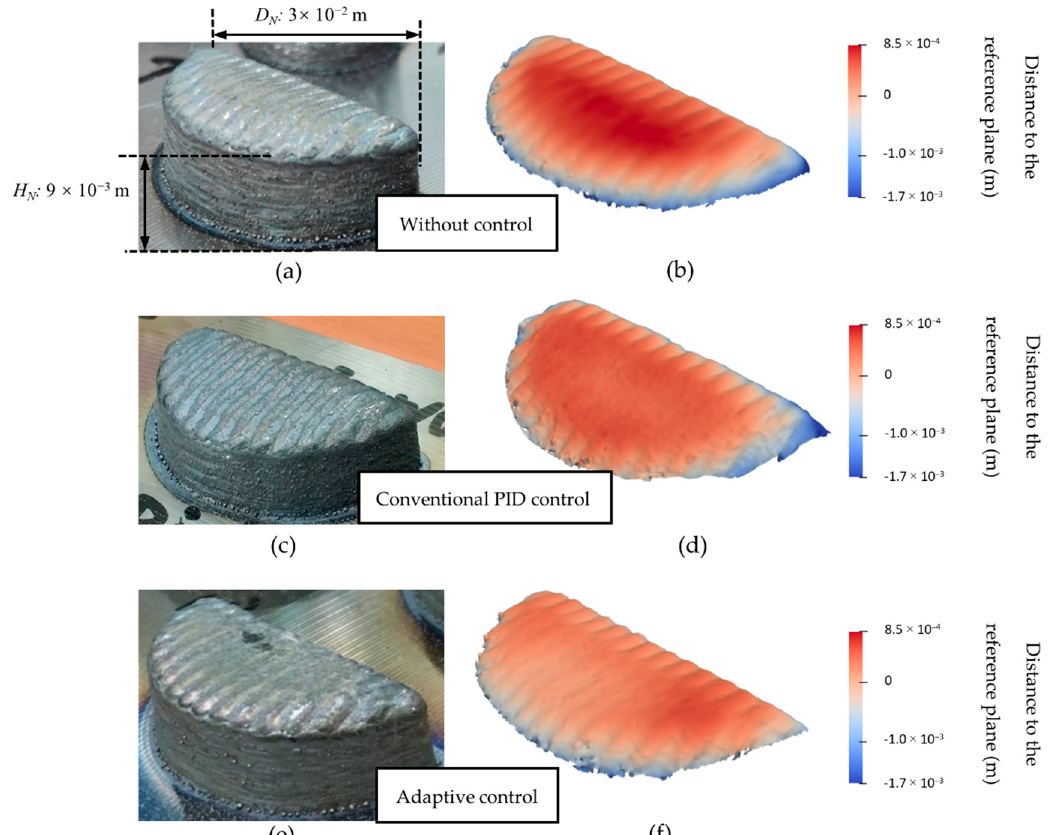
Figure 5. Samples of Experiment 1 (solid semicylinder with the profile tool path, 316 L stainless steel). ( a ) The sample fabricated without control; ( b ) The reconstructed surface of the uncontrolled sample; ( c ) The sample fabricated with a conventional proportional–integral–derivative (PID) controller; ( d ) The reconstructed surface of the conventional PID controlled sample; ( e ) The sample fabricated with the proposed adaptive controller; ( f ) The reconstructed surface of the adaptively controlled sample.